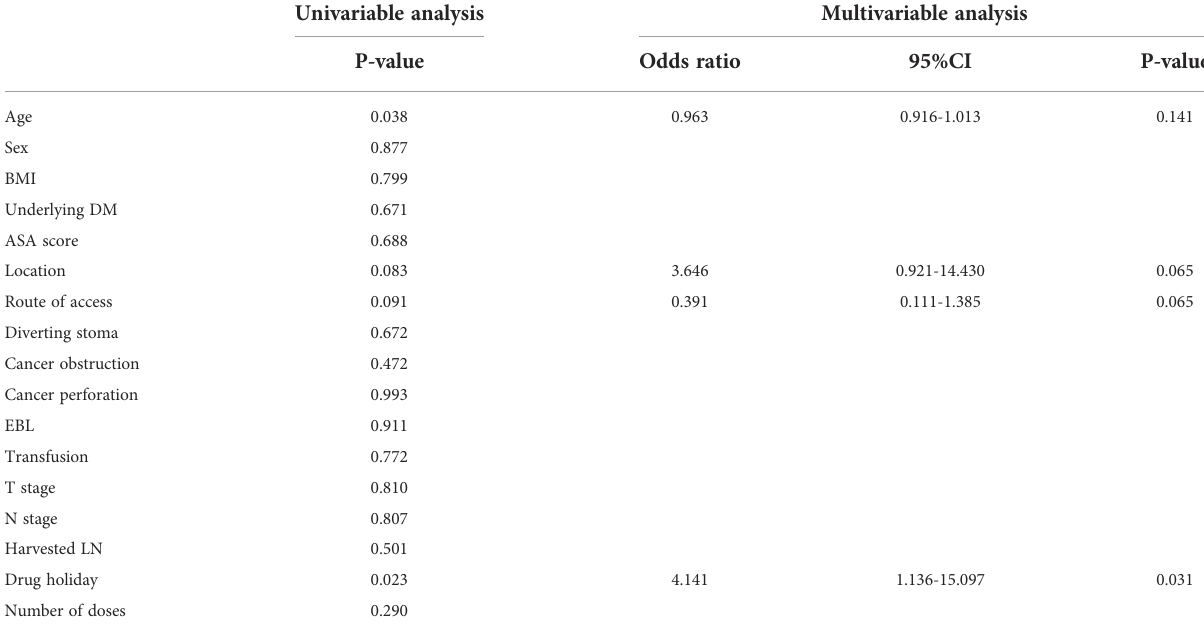
TABLE 5 Univariable and multivariable analyses of factors associated with anastomosis site leakage in the bevacizumab group. Univariable